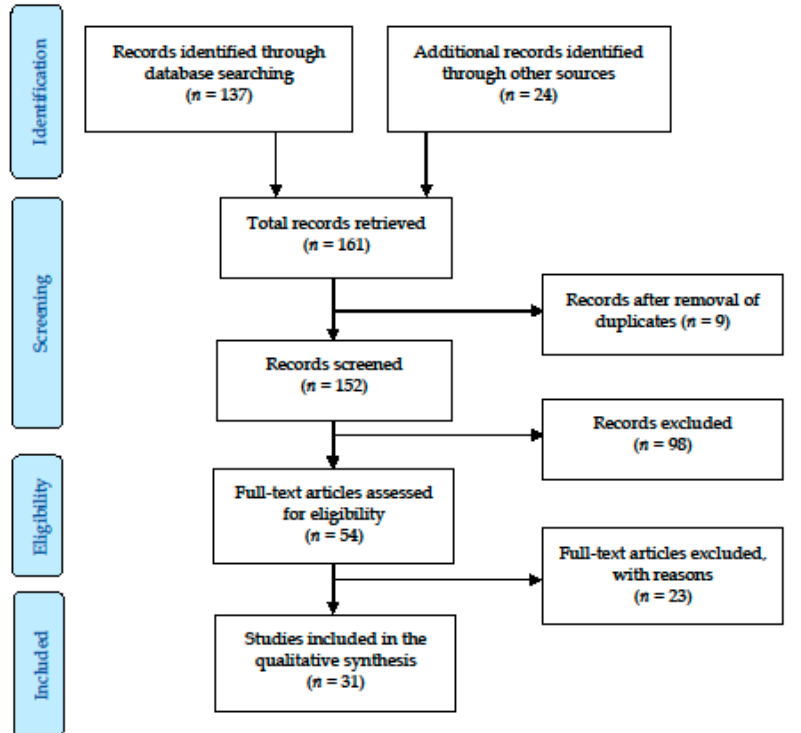
Figure 1. Flowchart of the included studies describing indoor radon concentrations.